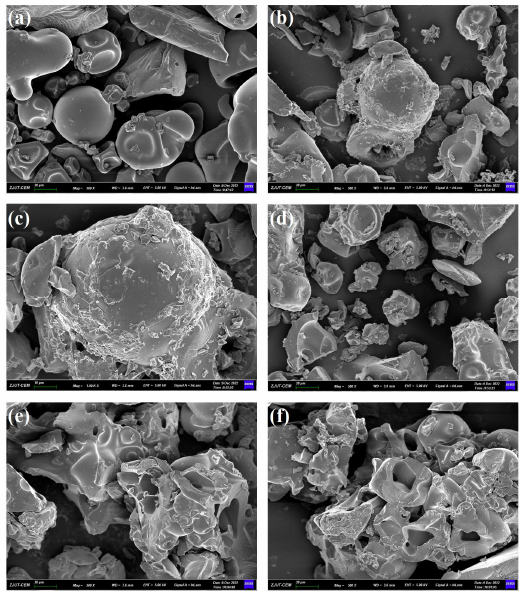
Figure 4. Scanning electron microscopy (SEM) images of different soybean meal powders. ( a ) SP 500 × ; ( b ) SSP 500 × ; ( c ) SSP 1000 × ; ( d ) PFSP 500 × ; ( e ) HFSP 500 × ; ( f ) FFSP 500 × . SP: soybean meal powder; SSP: sterilized soybean meal powder; PFSP: Pleurotus ostreatus fermented soybean meal